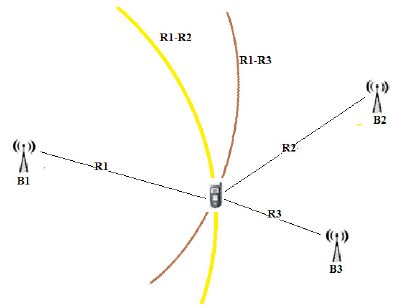
Figure 5. Time difference of arrival.